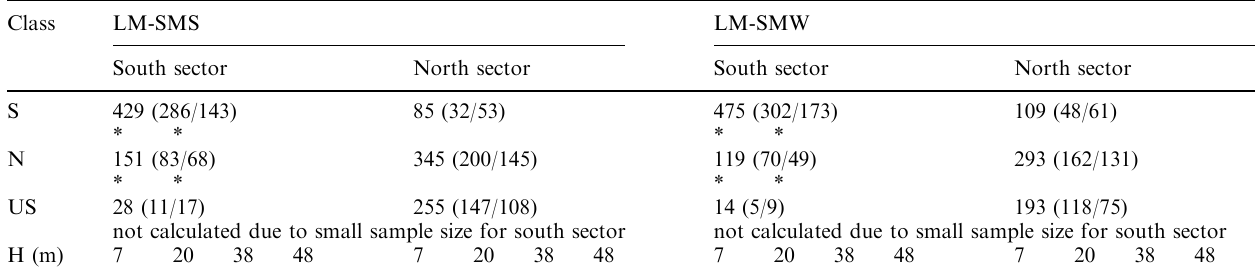
Table 1. Statistical summary of analysis of the wind speed distributions by stability class (S = stable, N = near-neutral, US = unstable) and wind direction [NORTH = flow over sea to all masts (wind direction: 285 (cid:176) –65 (cid:176) ), SOUTH = flow over land to LM and then over sea to SMS and SMW (wind direction: 135 (cid:176) – 195 (cid:176) )]. The first row for each stability class shows the total number of observations in that stability class by directional sector (e.g., there are 151 observations with near-neutral stability at both SMS and LM with flow from the south sector). The second row indicates the results of Kolmogorov-Smirnov test for the equality of